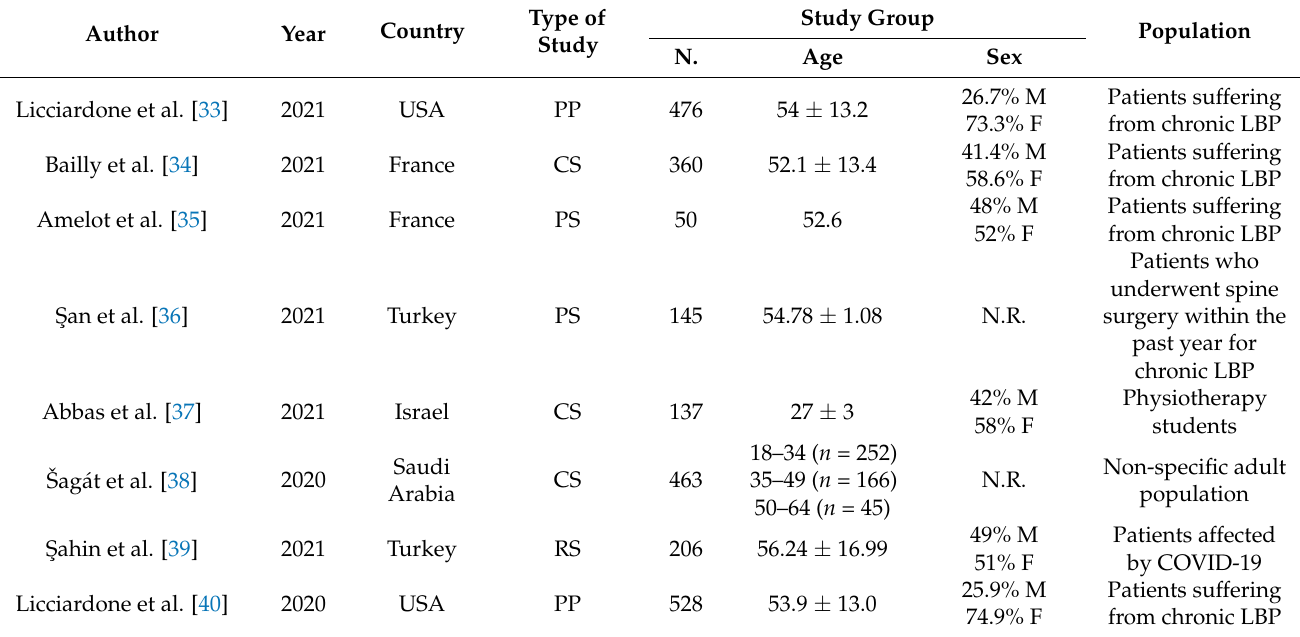
Table 1. Main characteristics of the included studies and